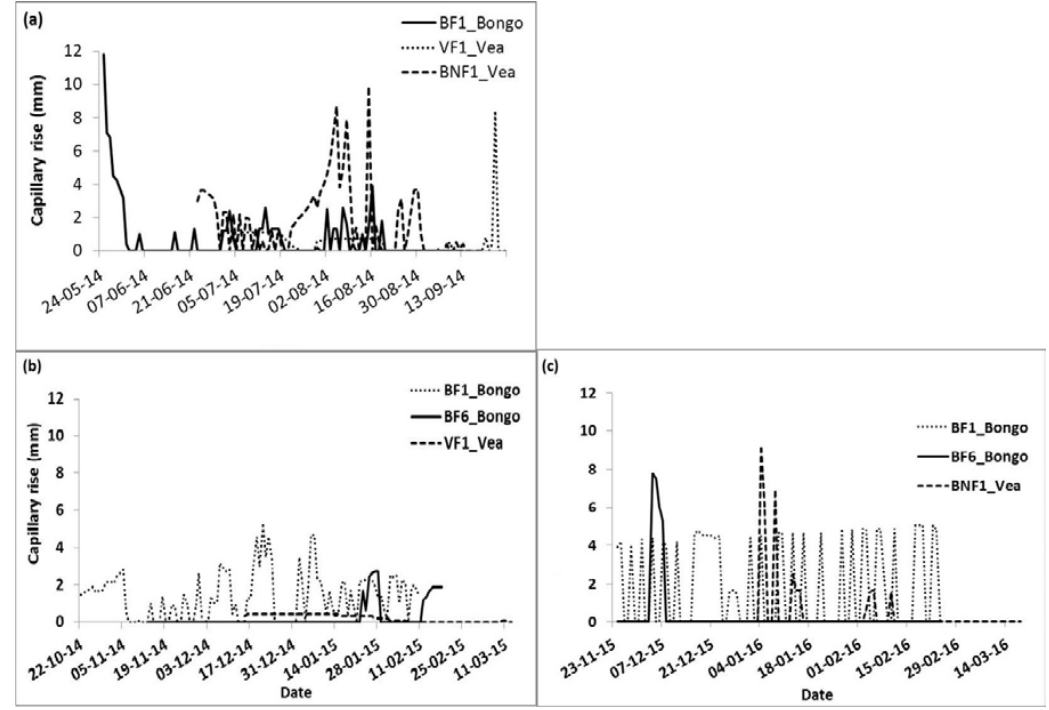
Figure 9. Daily groundwater contribution to the root-zone soil moisture of ( a ) maize in 2014; ( b ) tomato